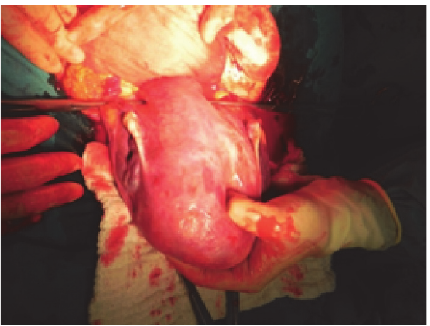
Figure 2: Insertion of